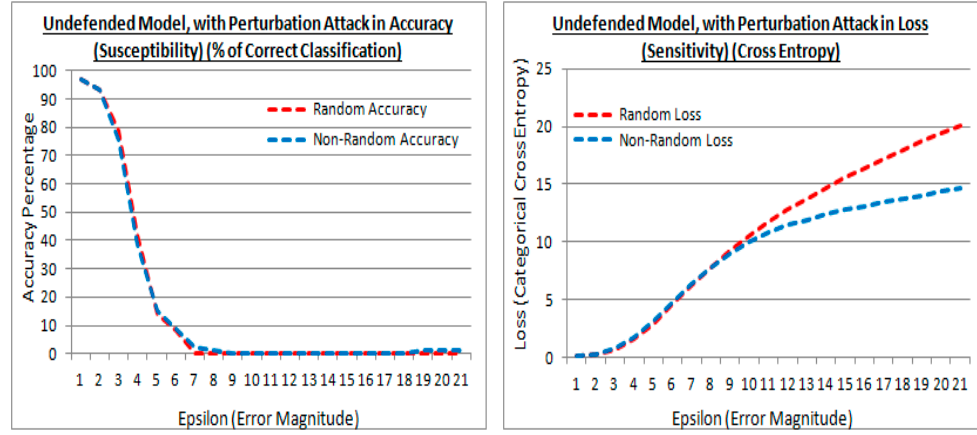
Figure 12. Accuracy and losses of an undefended model with epsilon increments under attack, for both the existing (random) and proposed (non-random) methods.